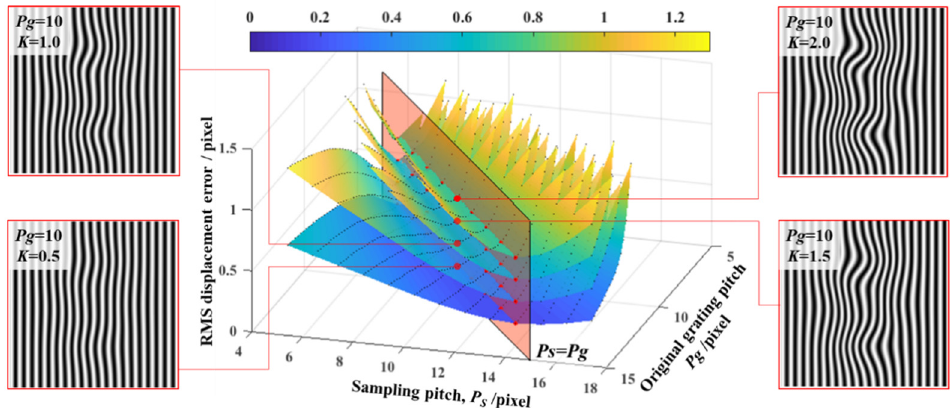
Figure 7. The RMS displacement errors when the original fringe pitch changes from 6 to 14 pixels and the sampling pitch changes from 4 to 17 pixels.